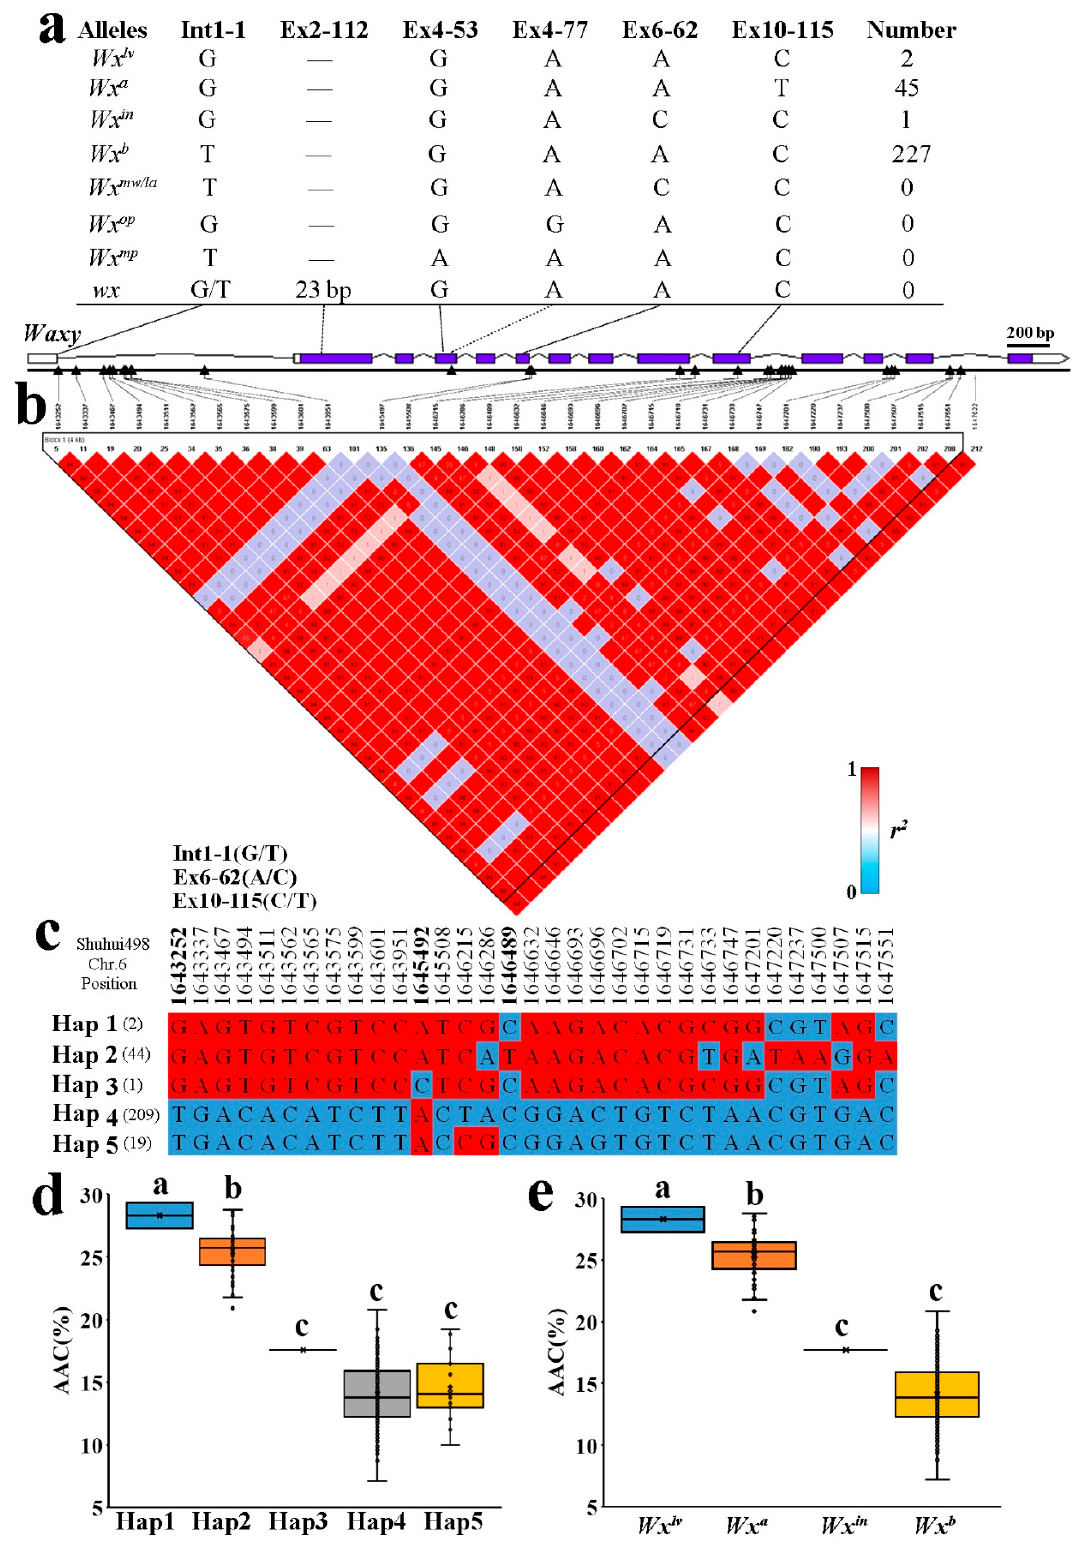
Figure 2. Analysis of different Wx alleles and haplotypes. ( a ) Wx allele types and numbers screened by KASP marker. ( b ) Linkage disequilibrium (LD) analysis. The r 2 value is reflected on the matrix diagram. ( c ) Results of haplotype analysis. ( d ) Apparent amylose content of different haplotypes. ( e ) Apparent amylose content of different allele types. Different letters indicate significant differences ( p < 0.05).